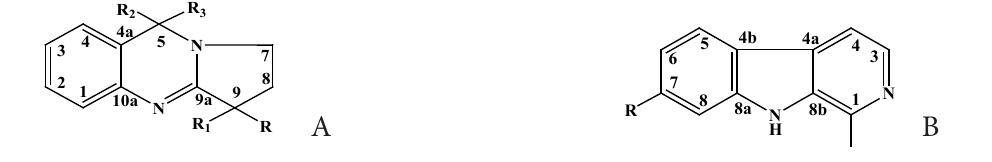
Fig. 2. Molecular structure of the quinazoline-type alkaloids (A): peganine (7,8,9,5-tetrahydro-pyrrolo[8,7-b] quinazoline- 9-ol; R=OH, R =R =R =H, 5 ), deoxypeganine (7,8,9,5-tetrahydro-pyrrolo [8,7-b] quinazoline; R= R 1 2 3 deoxyvasicinone (7.8.9-trihydro-5-oxo-pyrrolo[8,7-b]-quinazoline; R= R harmine (1-methyl-7-methoxy-β-carboline; R=OCH